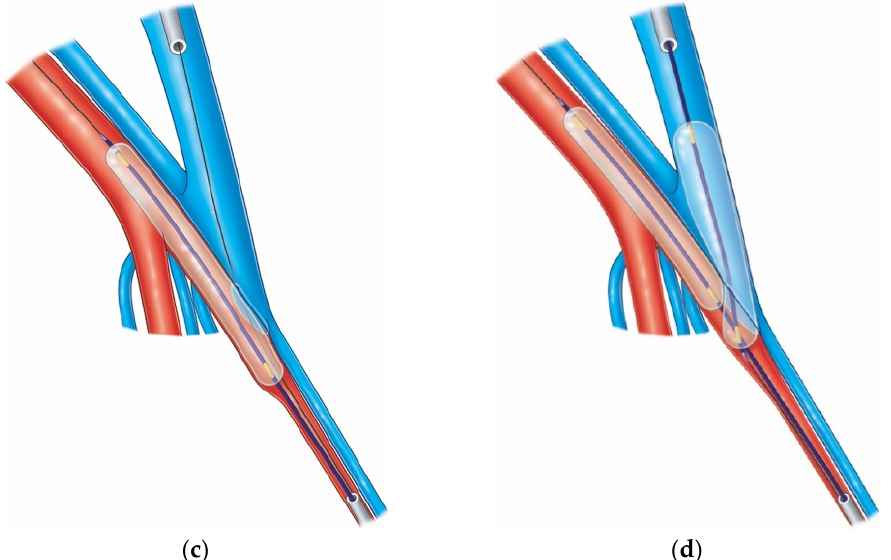
Figure 5. ( a – d ) Angioplasty of pAVF with radial access can allow dilatation of both outflow and inflow separately or simultaneously if needed with dual access reproduced with permission from Mallios et al. J Vasc Surg [20].